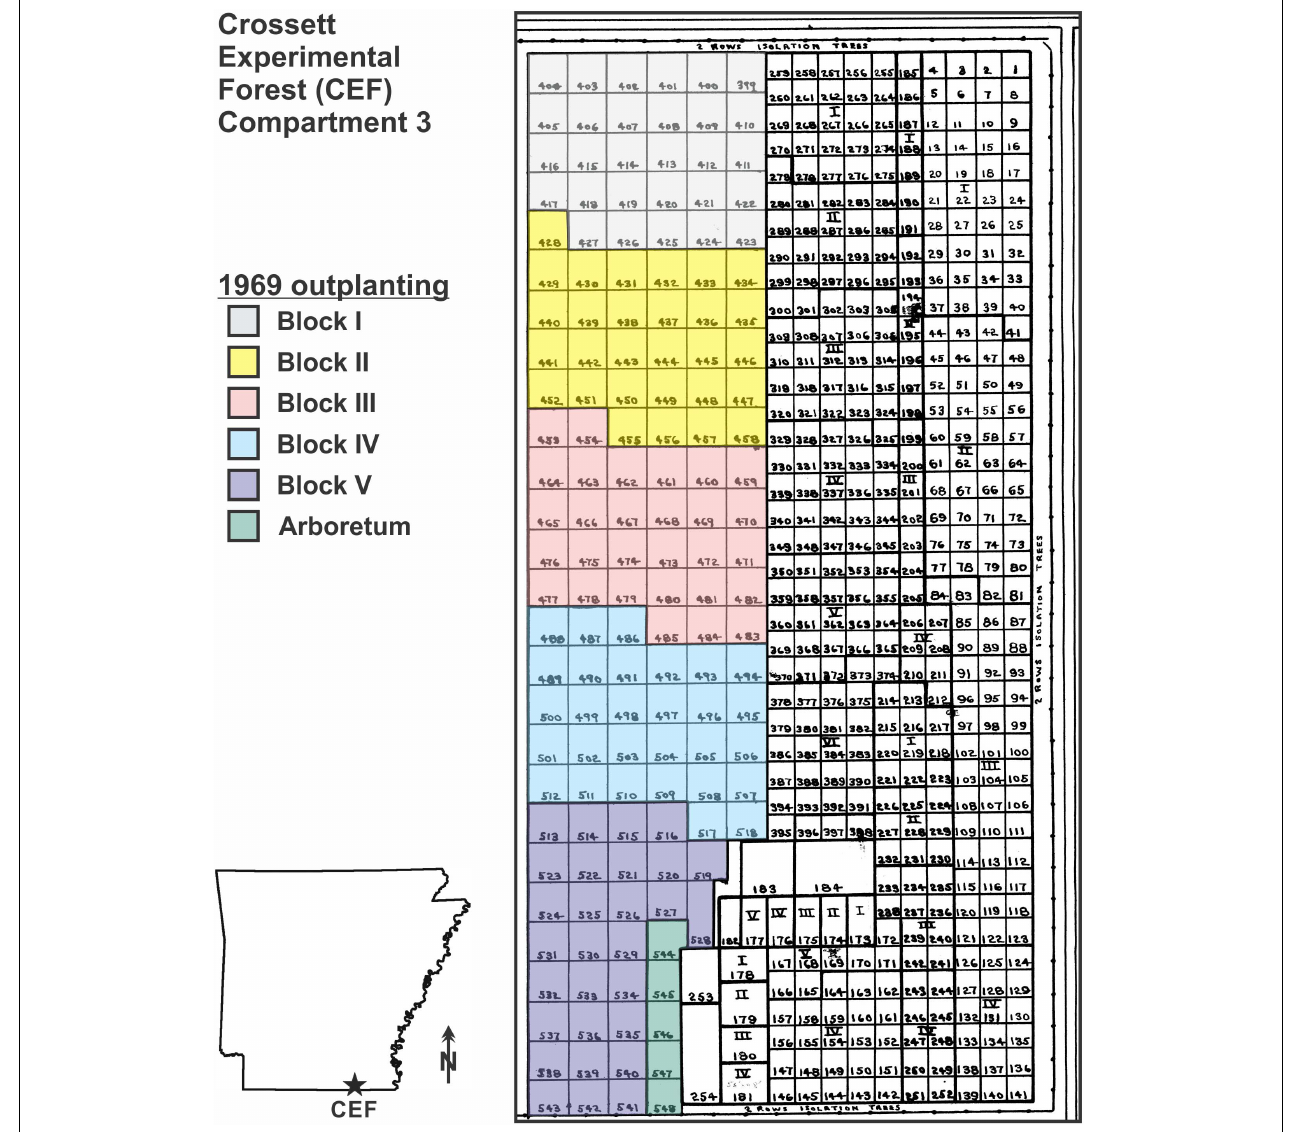
FIGURE 1 | Map of the 8.1-ha superior pine progeny test outplanting in the eastern half of Compartment 3 on the Crossett Experimental Forest (CEF), southern Arkansas; the outplanting were established between 1966 and 1969 by Hoy Grigsby. The colored area on the west side is the 1969 outplanting; inset shows the layout of the 36-plot subsample of the 1969 outplanting sampled in January 2017 (48 years post-planting), with planting block and family code (see Table 1 ) indicated [for example, the Crossett woods-run pines (W29) in Block I were located in Plot